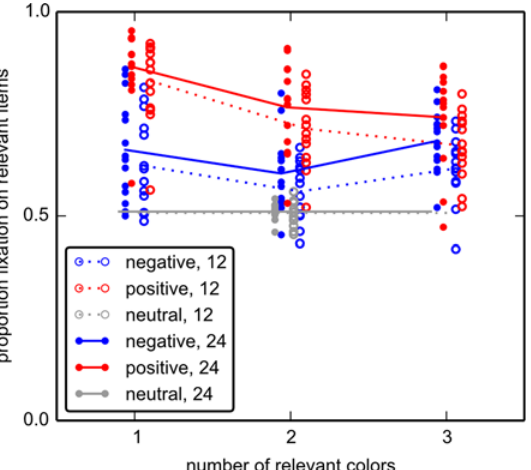
Fig 8. Proportion of fixations on relevant items in experiment 2. The proportion of fixations on relevant items for each cue type and array size are plotted over the number of relevant colors in the array. Cue type has the largest effect on guidance of gaze towards relevant items, with positive cues being more effective than negative cues, which in turn are more effective than neutral cues. Array size modulates this, so that with larger arrays, gaze is guided towards relevant items more efficiently.